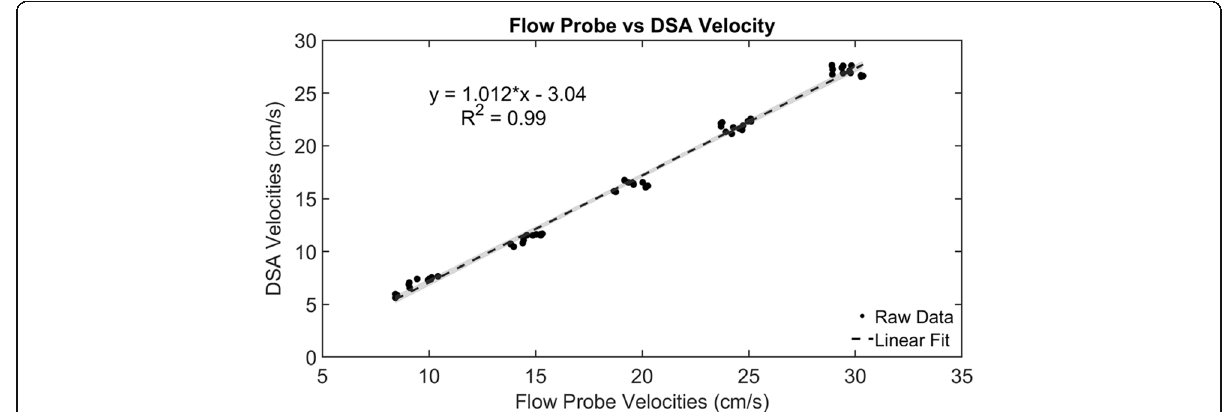
Fig. 2 Linear regression analysis between the flow probe velocities and the calculated qDSA velocities. The shaded region represents the 95% confidence interval. The data were found to be strongly correlated ( r = 0.996, p <